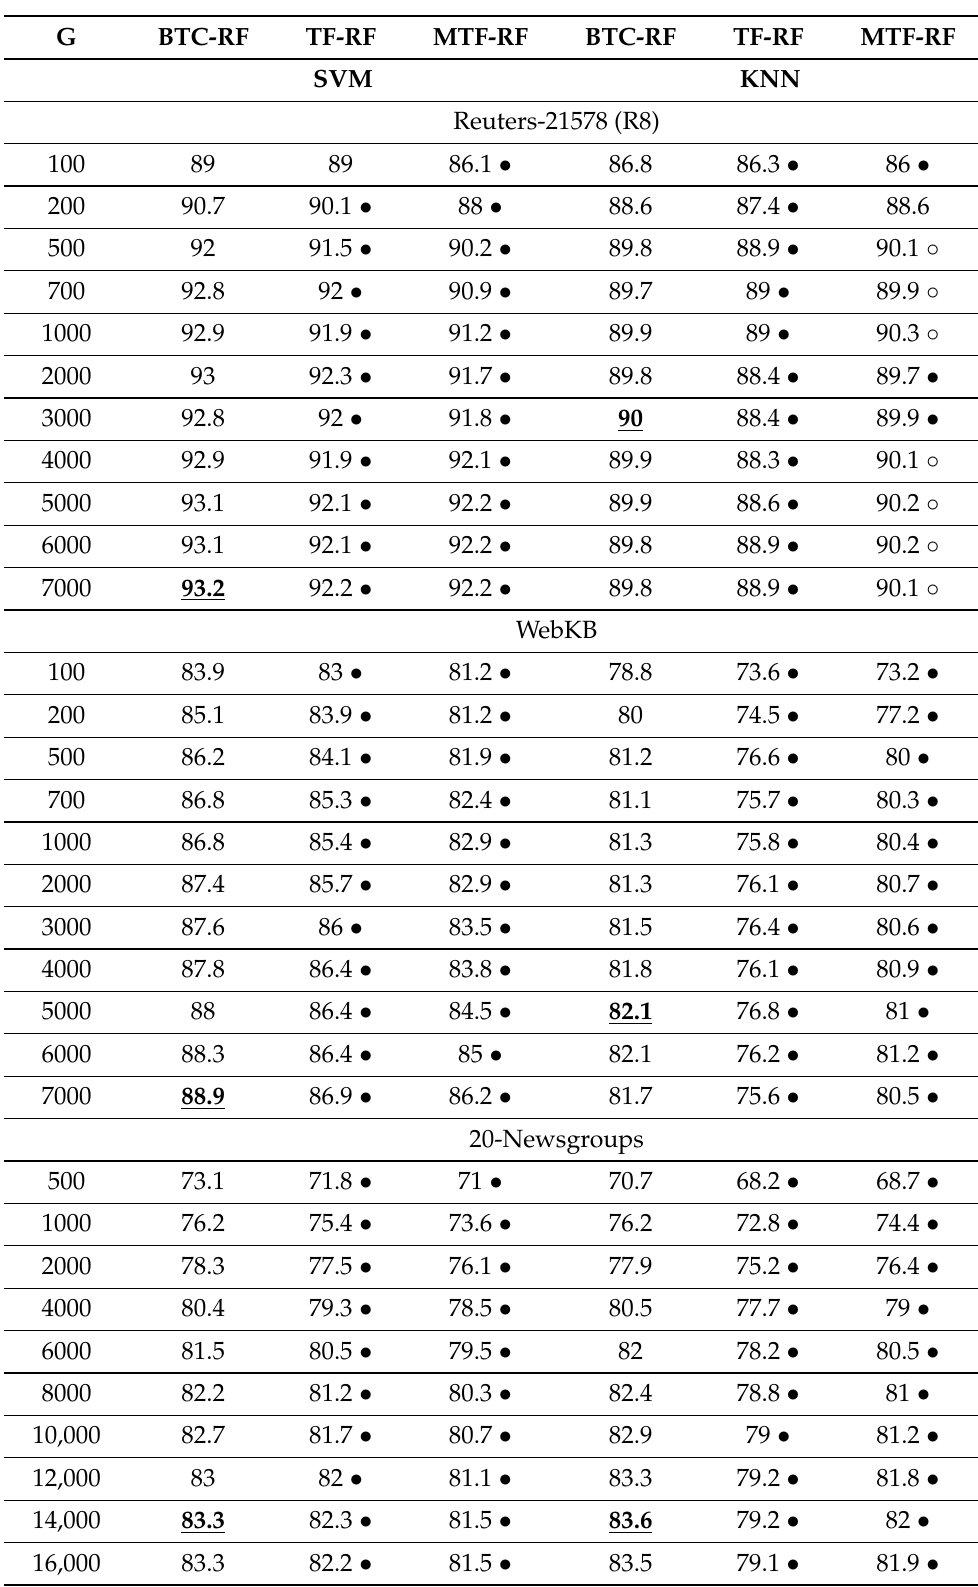
Table 8. Performance comparison of BTC-RF vs. TF-RF vs.